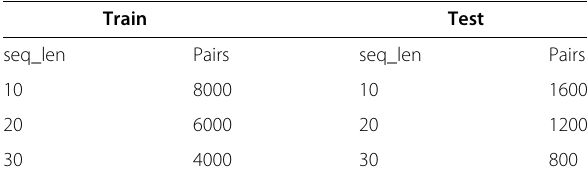
Table 5 Overview of the ADFA-LD dataset